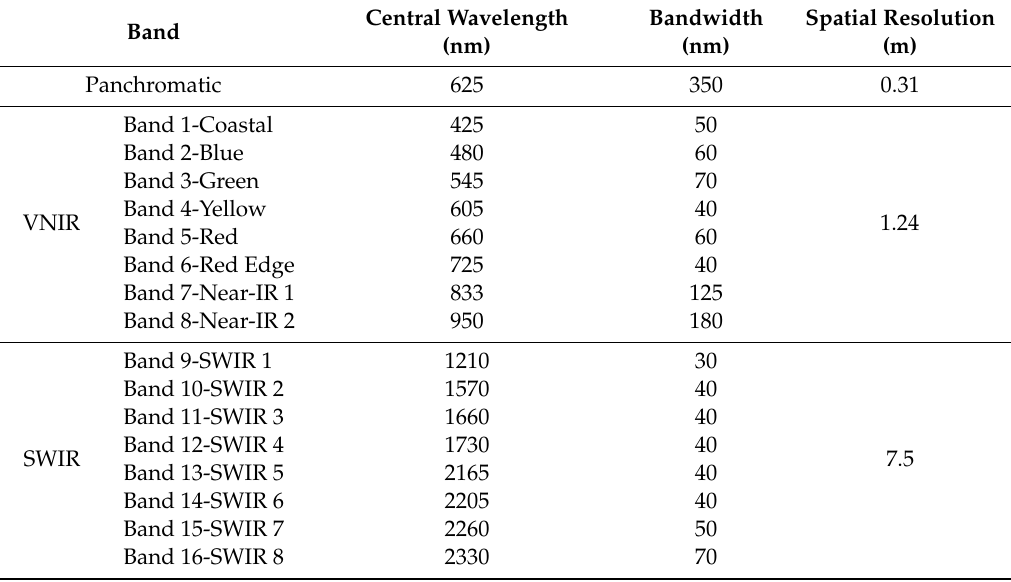
Table 1. Specification of Worldview-3 satellite imagery.